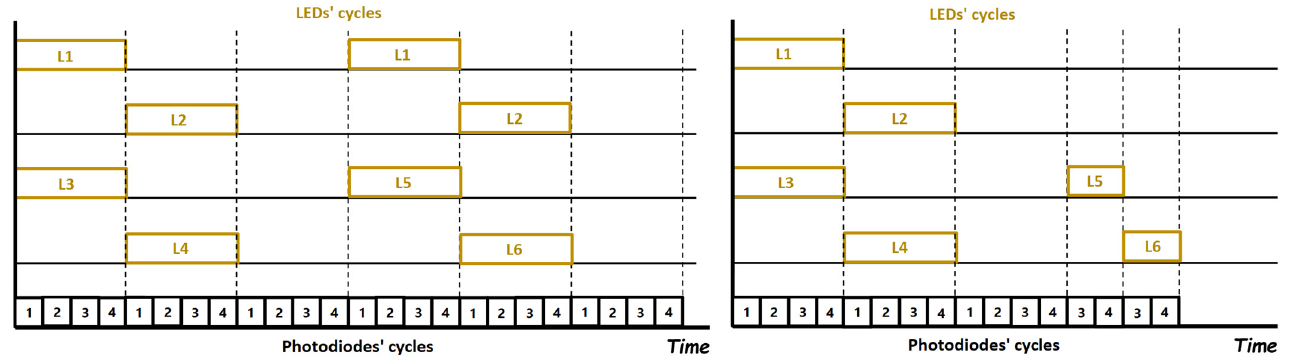
Figure 2. Two possible modes of an LED timing diagram for a device with new cerebral optical probes with one photodiode: L1,L2—peripheral tissue probe LEDs are switched ON; L3–L6—cerebral tissues probe LEDs are switched ON. 1–6—collection of signals from photodiodes: 1,2—peripheral tissue probes, 3,4—cerebral tissue probes.